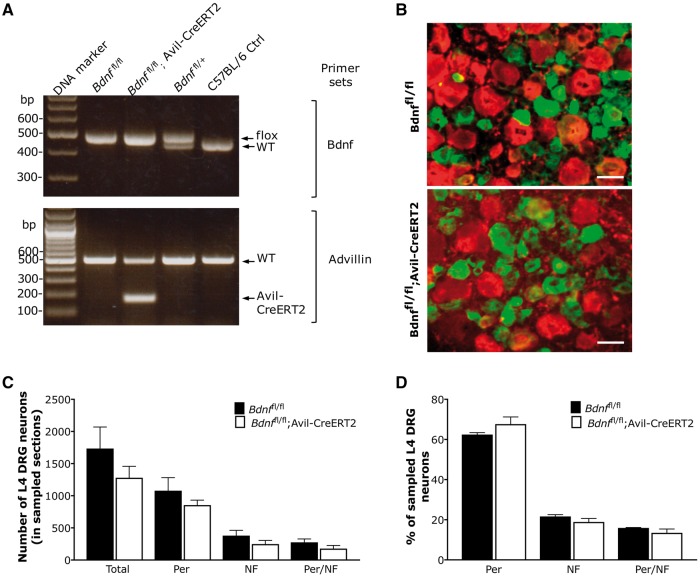

Characterization of BDNF knockout mice. (A) Genotyping analysis with PCR. The representative gel analysis of PCR products using both the BDNF primer set and the Avil-CreERT2 primer set is shown in top and bottom panels, respectively. Mice homozygous for the floxed Bdnf band and heterozygous for the Avil-CreERT2 band were defined as Bdnffl/fl; Avil-CreERT2 mice. Mice only homozygous for the floxed Bdnf band were defined as Bdnffl/fl littermate controls. The genomic DNA from C57BL/6J wild-type (WT) mice and heterozygous floxed Bdnf (Bdnffl/+) mice were used as controls. (B) DRG sections were labelled with large diameter DRG neuron marker neurofilament (in red), and small-medium diameter DRG neuron marker peripherin (in green). Scale bar = 50 μm. (C) The total number of DRG neurons either expressing neurofilament (NF), or peripherin (Per) in sampled L4 DRG sections, or both NF and Per were counted, respectively. (D) The proportions of neurofilament and peripherin positive neurons in sampled L4 DRG sections are presented. Both total number and proportion are normal in BDNF knockout mice (n = 3) compared to littermate controls (n = 3). Data were analysed with Student’s t-test and P > 0.05. Additional images—for colourblind readers—are available in the Supplementary material.